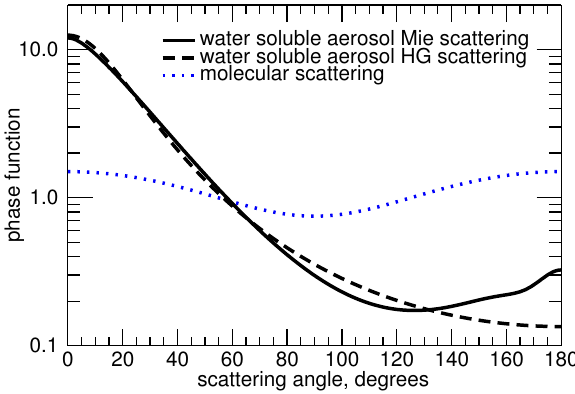
Fig. 1: Phase functions at 550 nm for molecules and dry Fig. 1. Phase functions at 550nm for molecules and dry water solu- water soluble aerosols derived from the Henyey-Greenstein ble aerosols derived from the Henyey-Greenstein (HG) approxima- = 0 . 63 and the exact (HG) approximation with g aer = 0 . 63 and the exact Lorenz-Mie 550 nm tion with g aer 550nm Lorenz-Mie theory.